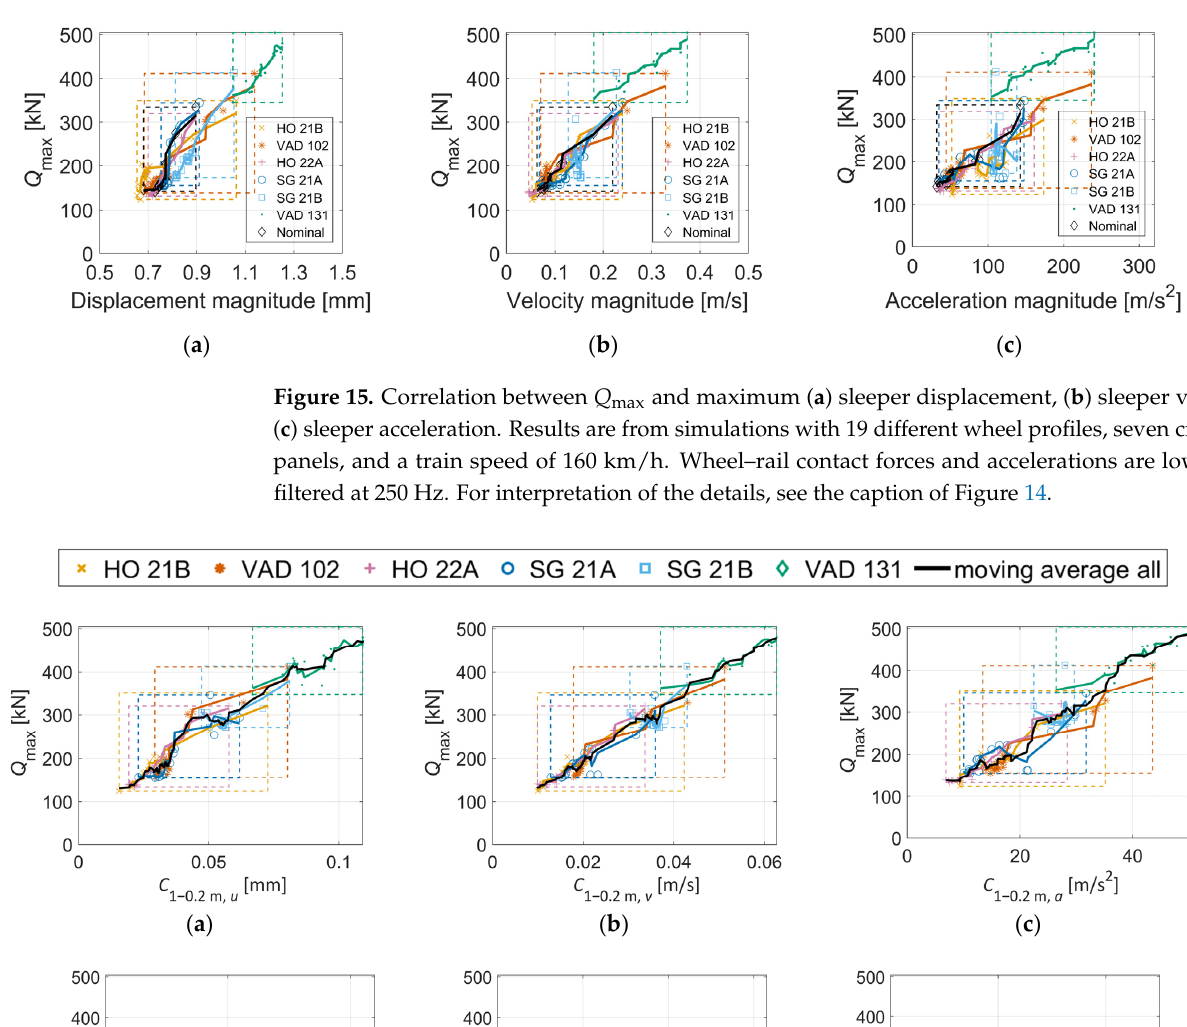
Figure 15. Correlation between Q max and maximum ( a ) sleeper displacement, ( b ) sleeper velocity, ( c ) sleeper acceleration. Results are from simulations with 19 different wheel profiles, seven crossing panels, and a train speed of 160 km/h. Wheel– rail contact forces and accelerations are low-pass-filtered at 250 Hz. For interpretation of the details, see the caption of Figure 14.